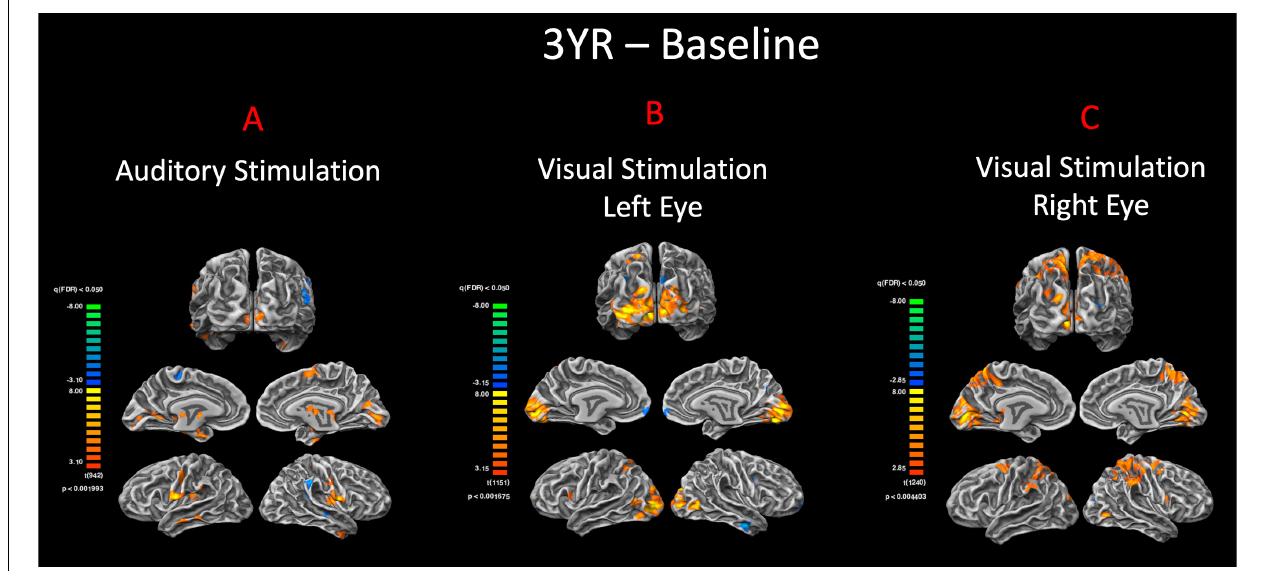
FIGURE 4 | Pre– and post–gene therapy comparison for auditory and visual stimulations. Direct group comparisons of pre– and 3 years post–retinal gene therapy were performed using the FX group-level analysis in response to (A) auditory and (B,C) visual stimulations. Group results are presented at an FDR-corrected p < 0.002 and p < 0.005 for auditory and vision, respectively ( q < 0.05). In response to the same auditory stimulation, RPE65 patients showed increased bilateral auditory activation within the auditory cortex, as well as significant level of cross-modal activations along the bilateral calcarine sulci for their 3-year time point. The group comparison of the visual stimulation results between the baseline and 3 years post–gene therapy time points showed significantly more activations in and around the visual cortex for both the left and right eyes (left > right) 3 years after retinal gene